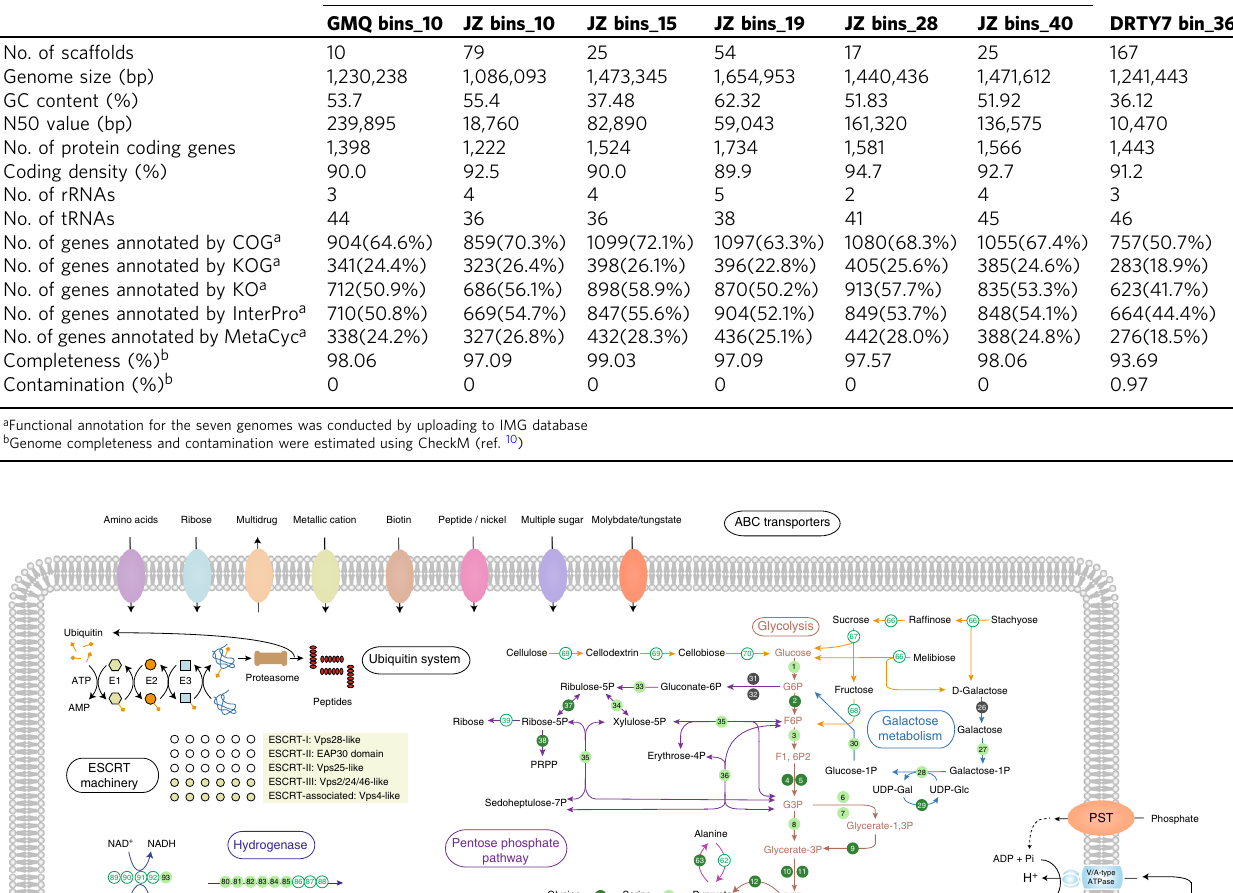
Table 1 General genomic features of the Aigarchaeota and Thaumarchaeota bins reconstructed from the metagenome assembly Bins